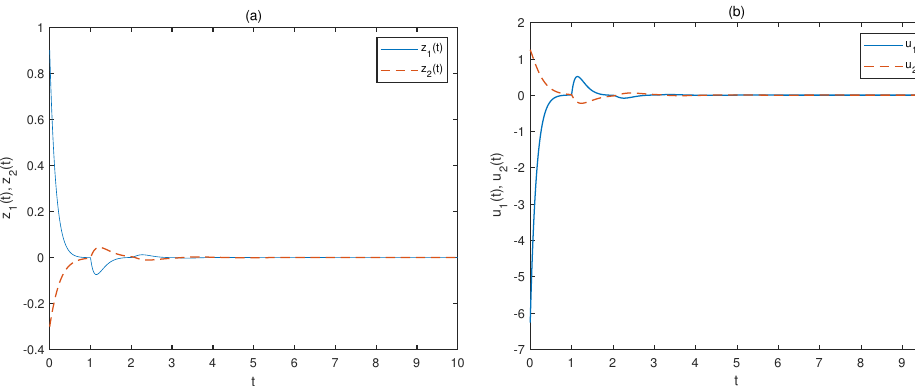
Figure 3. Trajectories of ( a ): z ( t ) ; ( b ): u ( t ) of Example 1 based optimization scheme A.